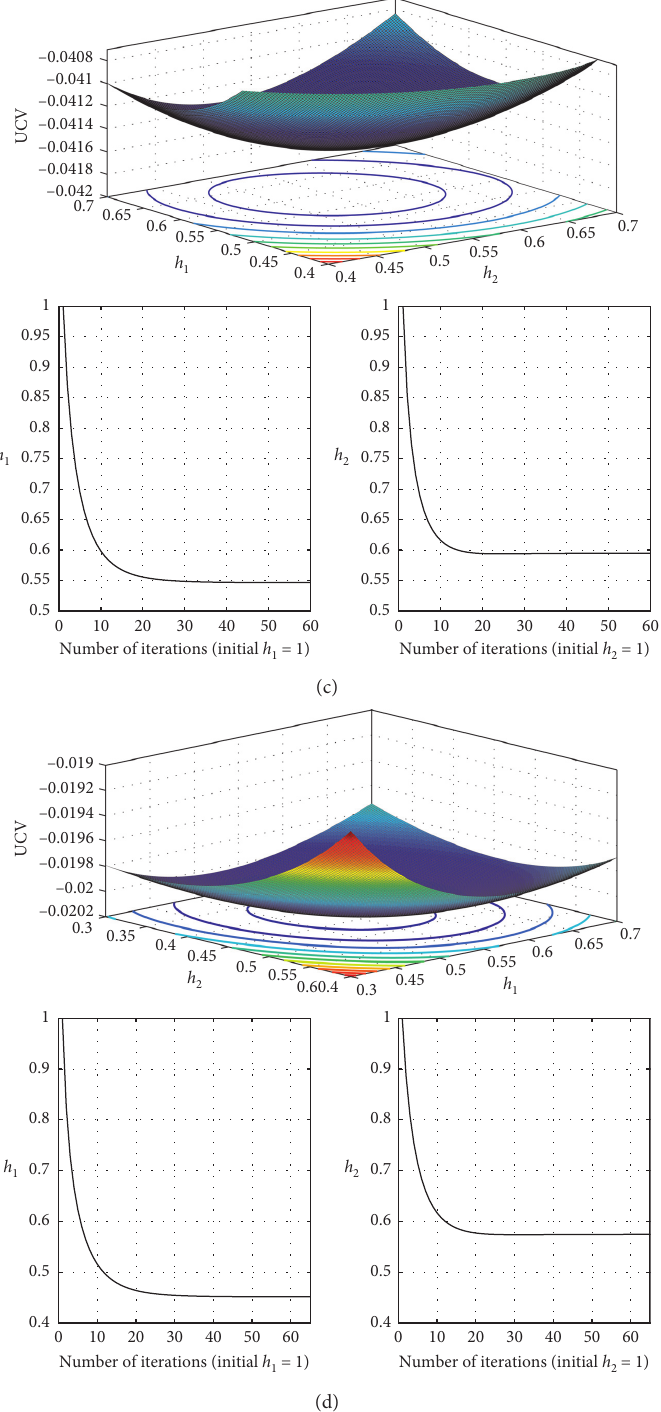
Figure 3: The convergence of Algorithm 1 on 2 univariate and 2 multivariate distributions (a) Beta distribution ( α � 2 , β � 5 , and h � 0 . 048 ) . (b) Normal distribution ( μ � 0 , σ � 1 , and h � 0 . 331 ) . (c) 2-dimensional Bimodal normal distribution ( Θ ( 1 ) � (− 2 . 5 , − 2 . 5 ) , � ε � 1/2 , h � 0 . 546 and h � 0 . 595). (d) 2-dimensional Quadrimodal normal Θ ( 2 ) � ( 2 . 5 , 2 . 5 ) , Σ ( 1 ) and Σ ( 2 ) are the identity matrices ε 1 2 1 2 distribution ( Θ ( 1 ) � (− 2 . 5 , − 2 . 5 ) , Θ ( 2 ) � ( 2 . 5 , 2 . 5 ) , Θ ( 3 ) � (− 2 . 5 , 2 . 5 ) Θ ( 4 ) � ( 2 . 5 , − 2 . 5 ) , Σ ( 1 ) , Σ ( 2 ) , Σ ( 3 ) , and Σ ( 4 ) are the identity matrices � ε � ε � ε � 1/4 , h � 0 . 451and h � 0 . ε 1 2 3 4 1 2